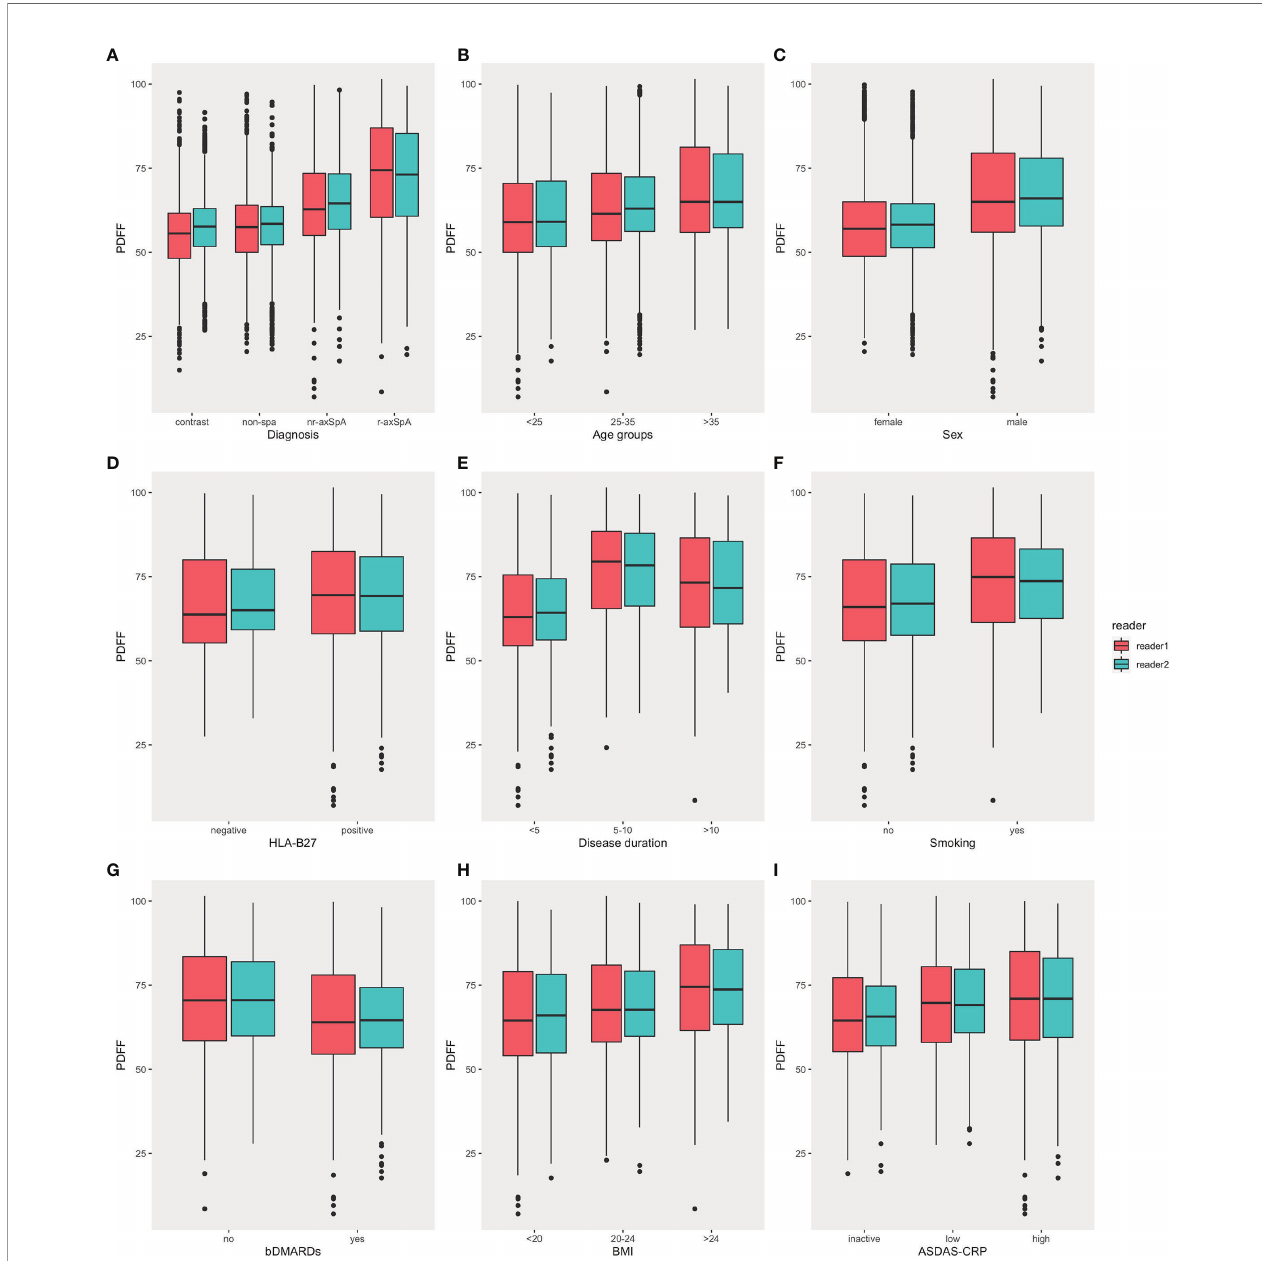
FIGURE 3 | Comparisons of PDFF values in the SIJs in different categories. (A) Diagnosis (B) Age (C) Sex (D) HLA-B27 (E) Disease duration (F) Smoking history (G) bDMARDs medication (H) BMI (I) ASDAS (PDFF, proton density fat fraction; bDMARDs, biologic disease-modifying antirheumatic drugs; ASDAS, Ankylosing Spondylitis Disease Activity